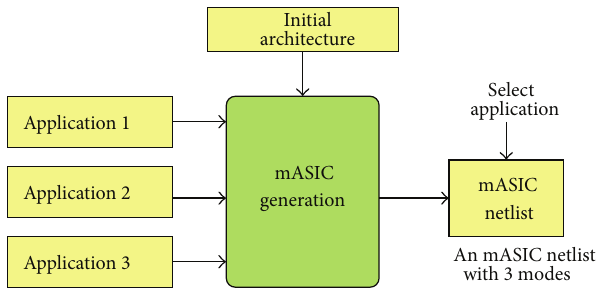
Figure 2: An illustration of mASIC generation concept.